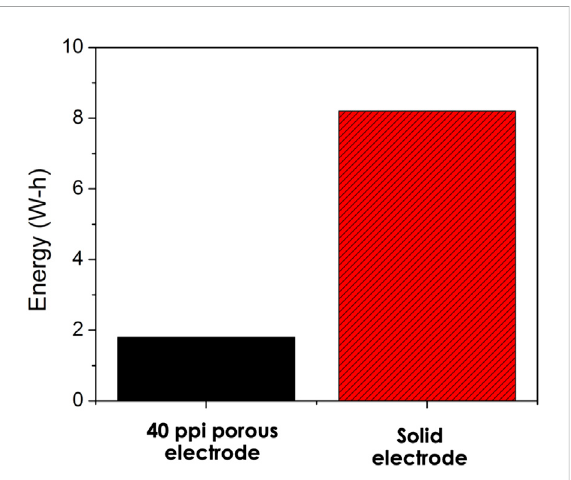
FIGURE 7 Energy comparison between solid electrode and the 40ppi porous electrode.